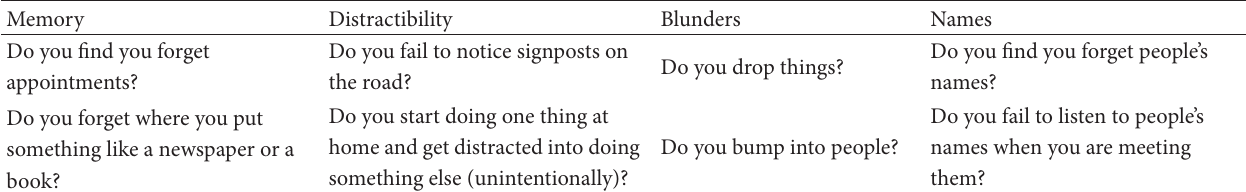
Table 1: Example items from the cognitive failures